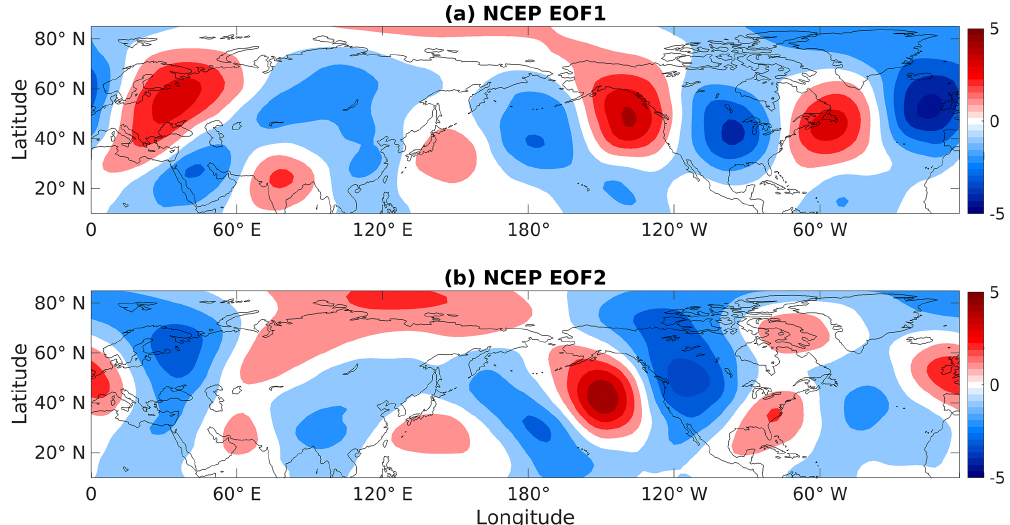
Figure 2. The first two empirical orthogonal functions (EOFs) of NCEP/NCAR monthly mean seasonal anomalies of 300hPa DJF meridional wind. Red shading is positive and blue is negative here and throughout, with intervals of 1ms − 1 .